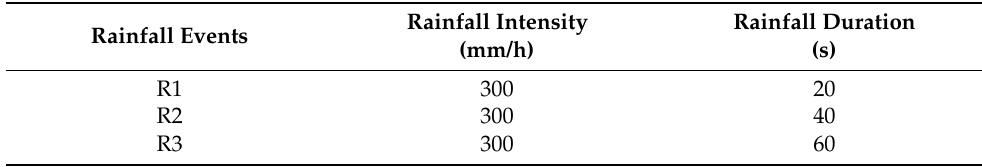
Table 2. Urban rainfall-runoff experiment: rainfall